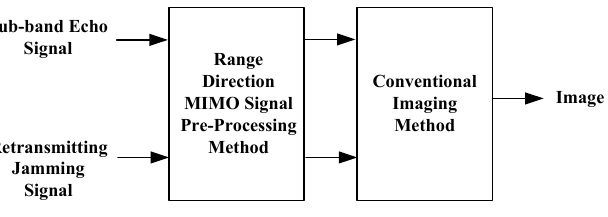
Figure 8. Anti-jamming efficiency analysis flowchart.